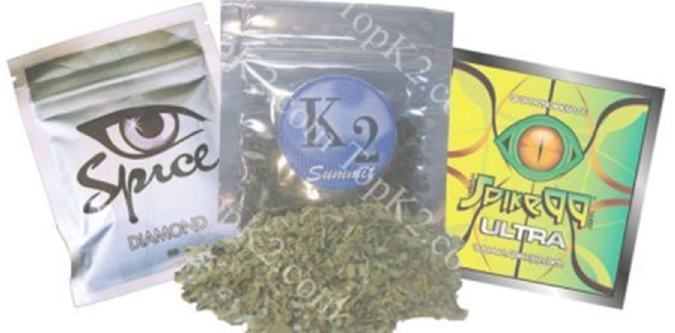
Figure 8. Examples of synthetic cannabimimetic-containing herbal formulations and packaging.